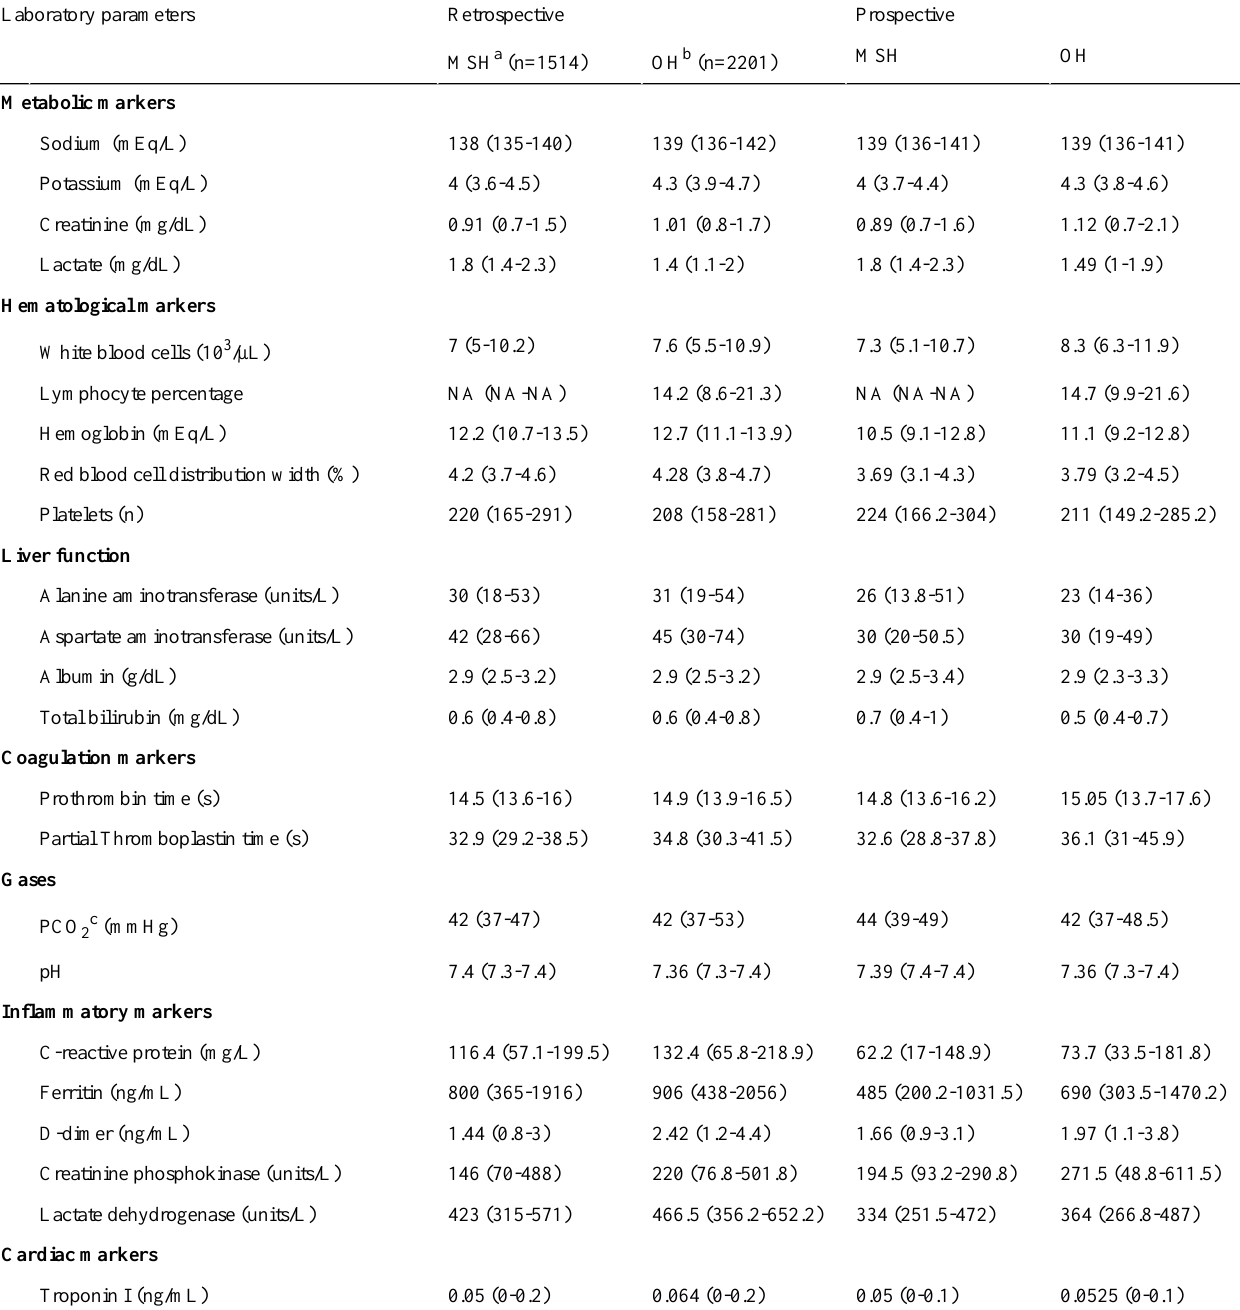
Table 2. Admission laboratory parameters of hospitalized patients with COVID-19 at baseline (N=4098), median